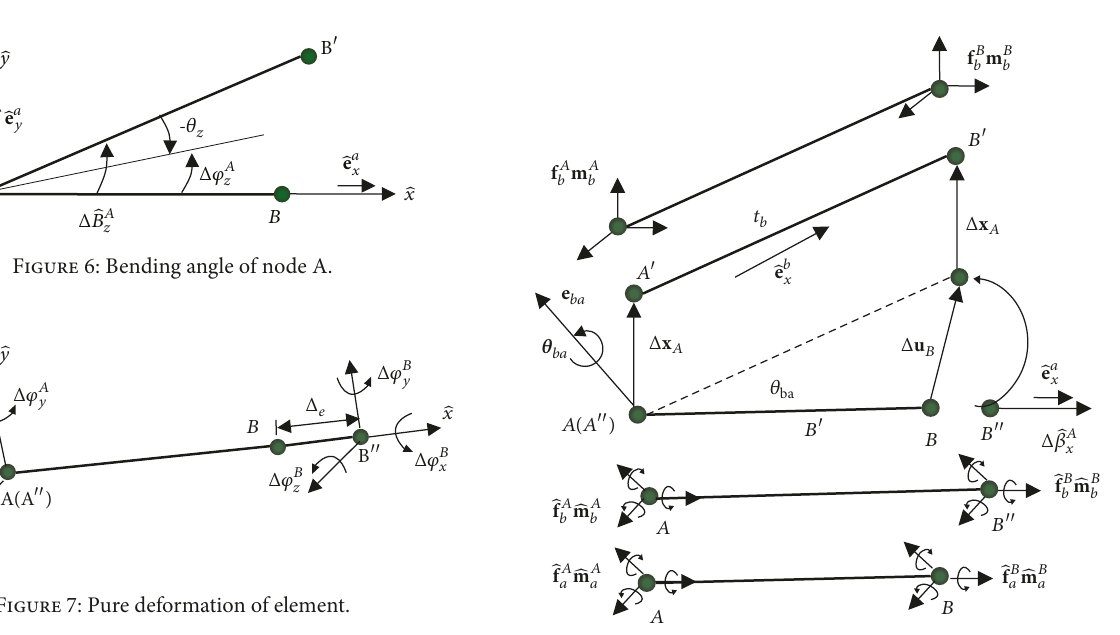
Figure 8: Translation and rotation in positive direction of space beam